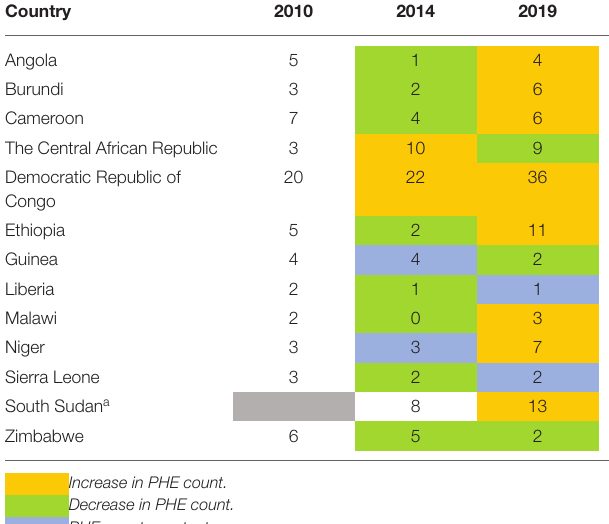
TABLE 1 | Total PHE counts stratified by year in 2010, 2014, and 2019.